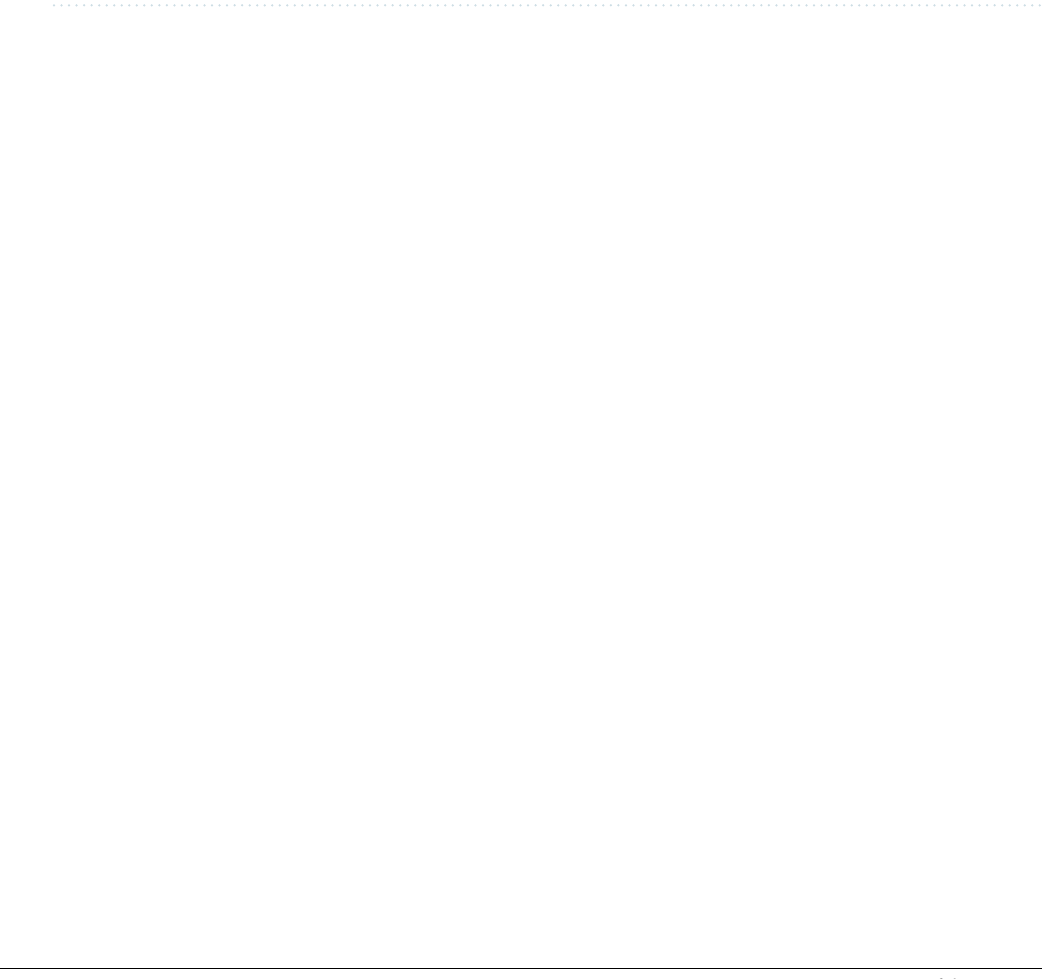
Table 3. Minor allele frequency for pathogenic and variants of unknown significance based on the